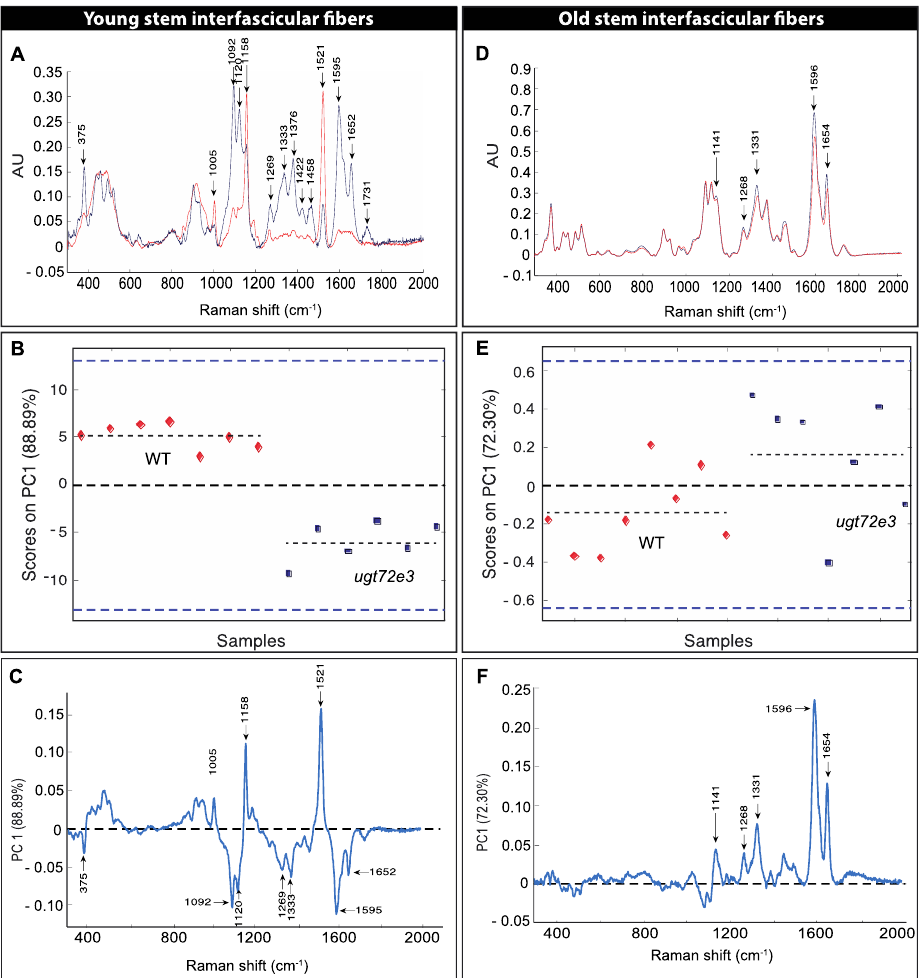
Figure 6. Raman microspectroscopy and principal component analyses (PCA) of WT and ugt72e3 interfascicular fibers. The results are shown for the young ( A – C ) and old ( D – F ) parts of the floral stem. ( A , D ): Baseline corrected average spectra from 300 cm − 1 to 2000 cm − 1 . The red spectrum corresponds to the WT and the blue to ugt72e3 . Arrows indicate major peak Raman shift wavenumbers. ( B , E ): Principal component one (PC1) scores of individual WT (red) and ugt72e3 (blue) spectra following PCA. Each point represented corresponds to an independent individual. ( C , F ): Loading vectors for PC1 indicating peaks contributing to the corresponding PC1 scores.